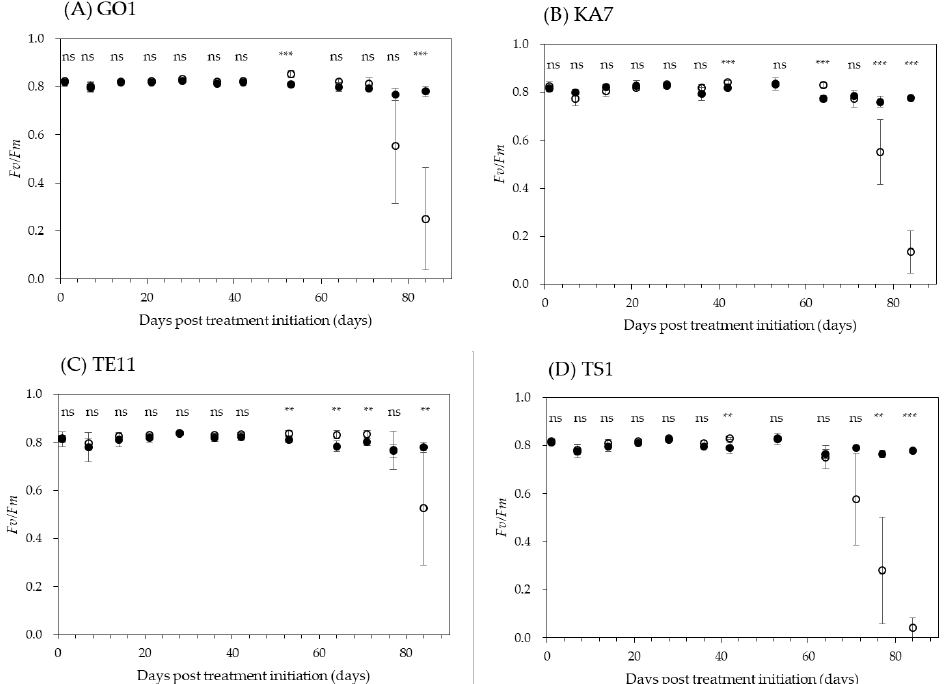
Figure 6. Temporal changes in the maximum photochemical quantum yield of photosystem II ( Fv / Fm ) in the four clones. ( A – D ) show the results obtained for GO1, KA7, TE11, and TS1, respectively. Open and closed circles denote the drought and control treatments. Statistical significance of the Fv / Fm between treatments at each dpt for each clone was evaluated by Student’s t -test (ns: not significant, **: p < 0.05, and ***: p <